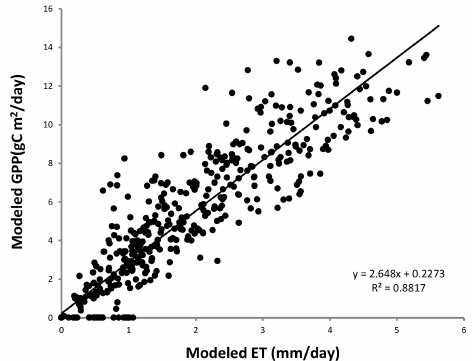
Figure 11. The relationship between simulated ET and GPP in two study